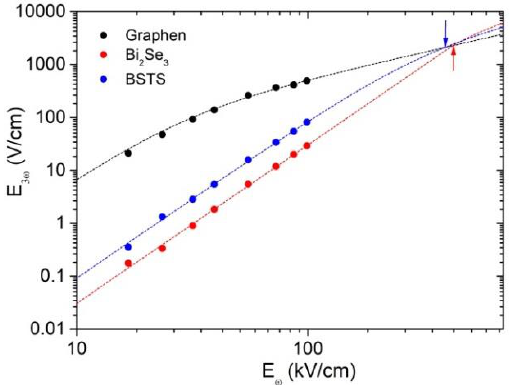
Figure 4. Third harmonic generation. Dependence of the peak amplitude of the outgoing third harmonic field on the pump field amplitude for graphene (black circles), BSTS (blue circles), and Bi 2 Se 3 (red circles). Colored dashed lines: corresponding fittings. The points of intersection of the extrapolation curves are marked with arrows.